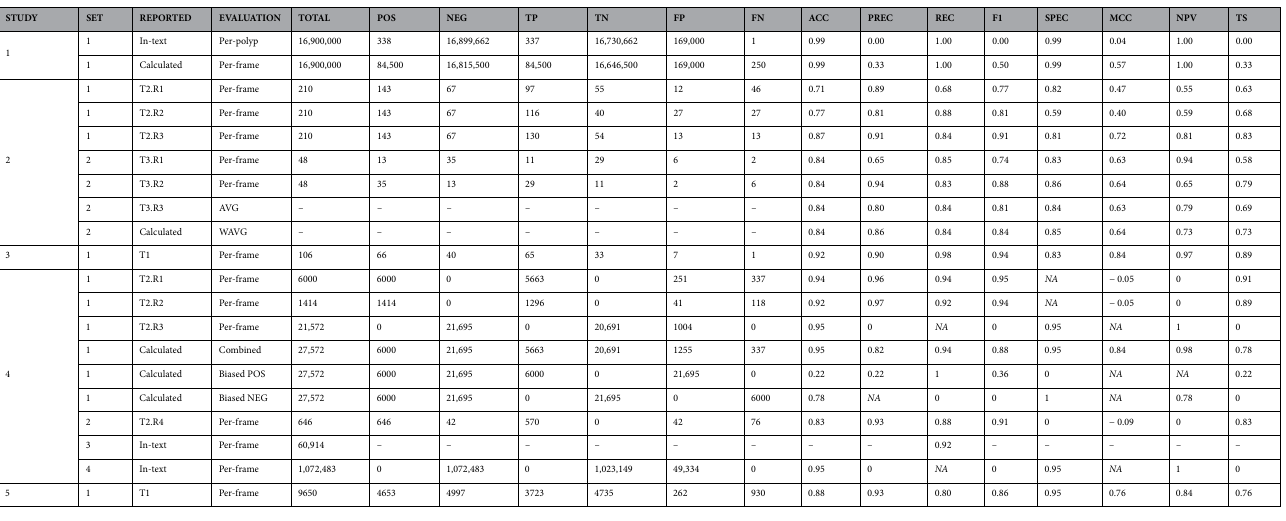
Table 2. The recalculated metrics of the selected papers. Columns represent the same as described in Table